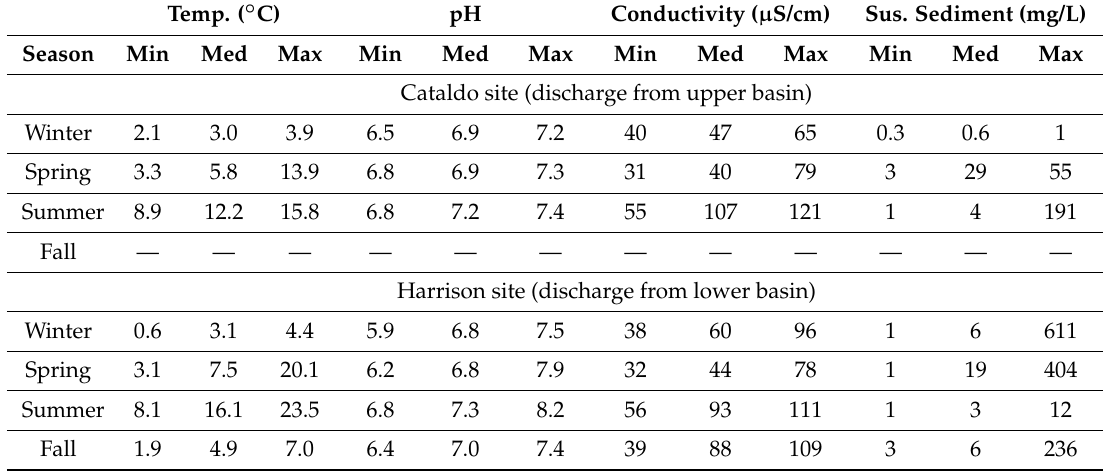
Table 1. Minimum, median, and maximum values of temperature, pH, conductivity, and suspended sediment for water collected at the Cataldo and Harrison streamgage sites from 2005–2015.